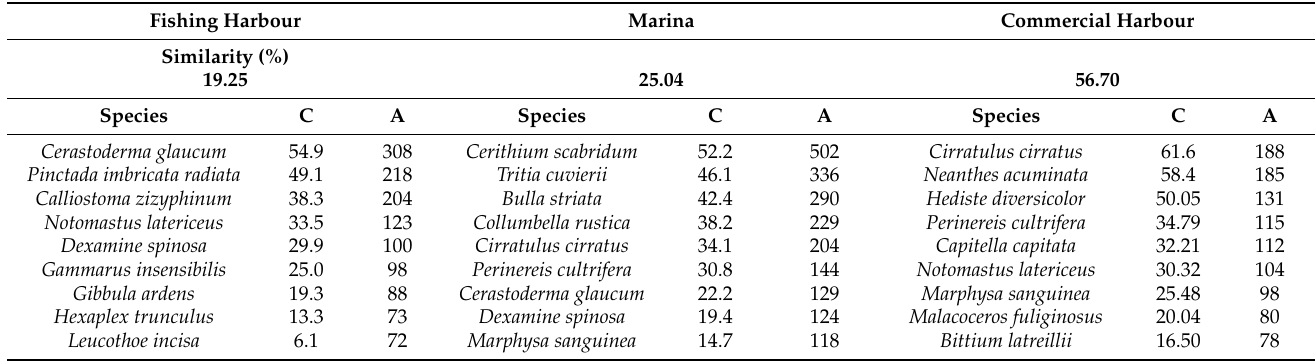
Table 4. MDS-formed groups, with indication of similarities within each group (%) and the most representative species (C%) contributing to the similarity within the group, determined by SIMPER analysis, with species mean abundance A (ind per 0.2 m − 2 ) for each